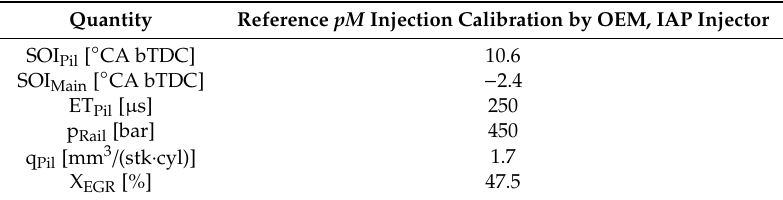
Table 4. Main parameters of the reference pM calibration at 1500 × 2, with IAP injectors. The main quantity is set directly by the test bench to obtain the desired bmep .